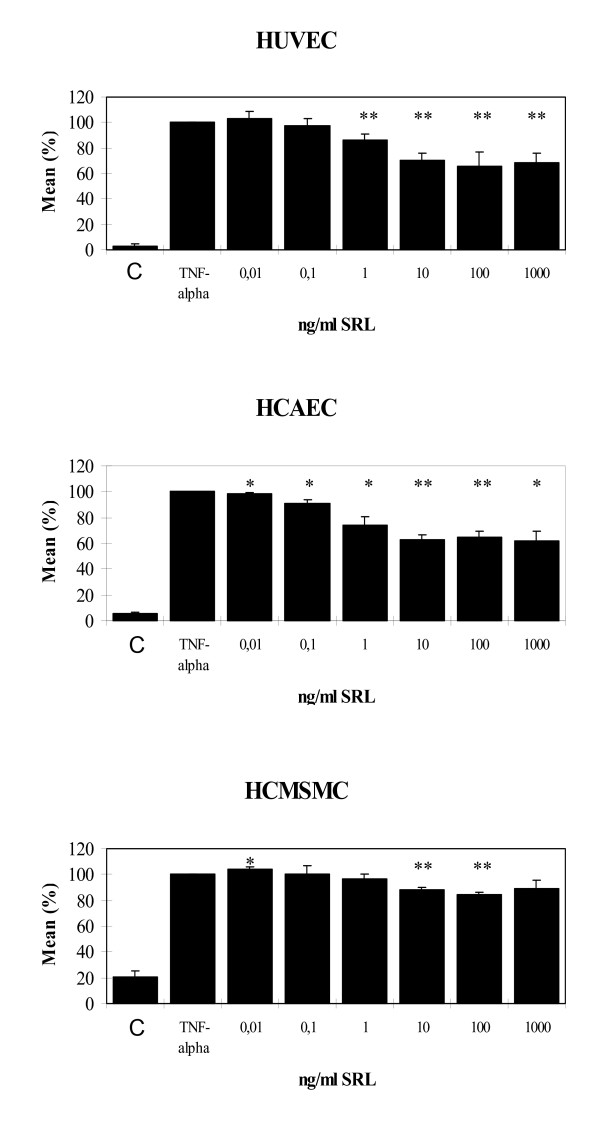
The effects of SRL (0.01, 0.1, 1, 10, 100, 1000 ng/ml) on TNF-α induced expression of ICAM-1 are demonstrated. A dose dependent significant inhibition of ICAM-1 expression was detected in HCAEC (SRL ≥ 0.01 ng/ml), HUVEC (SRL ≥ 1 ng/ml), and HCMSMC (SRL ≥ 10 ng/ml).